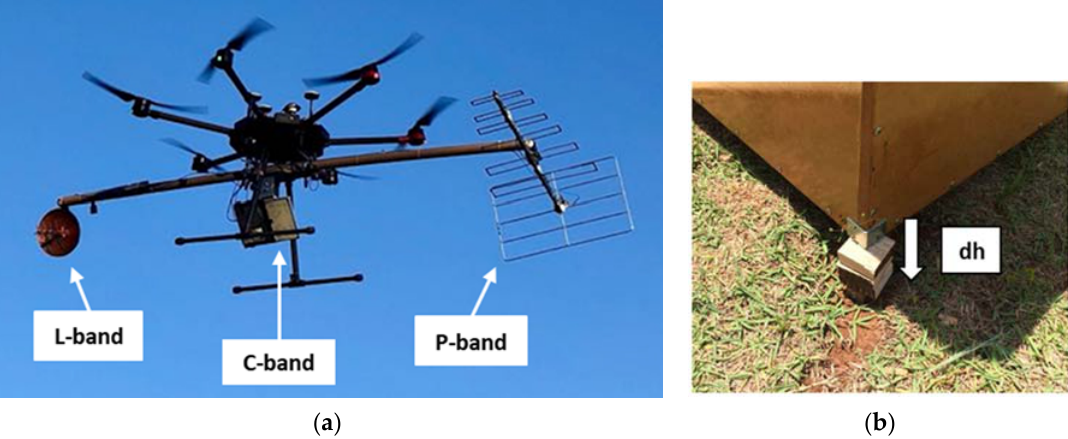
Figure 1. Experiment components. ( a ) Drone ‐ borne differential synthetic aperture radar interferometry (DInSAR) system [12] including one L ‐ band antenna with H and V dipoles; two interferometric C ‐ band antennae attached to the radar electronics; one P ‐ band antenna with an H dipole. ( b ) Corner reflector 2, which was lifted 4 cm off the ground during the second flight and 2 cm during the third flight. Displacement is positive (dh > 0) when terrain height decreases with time.